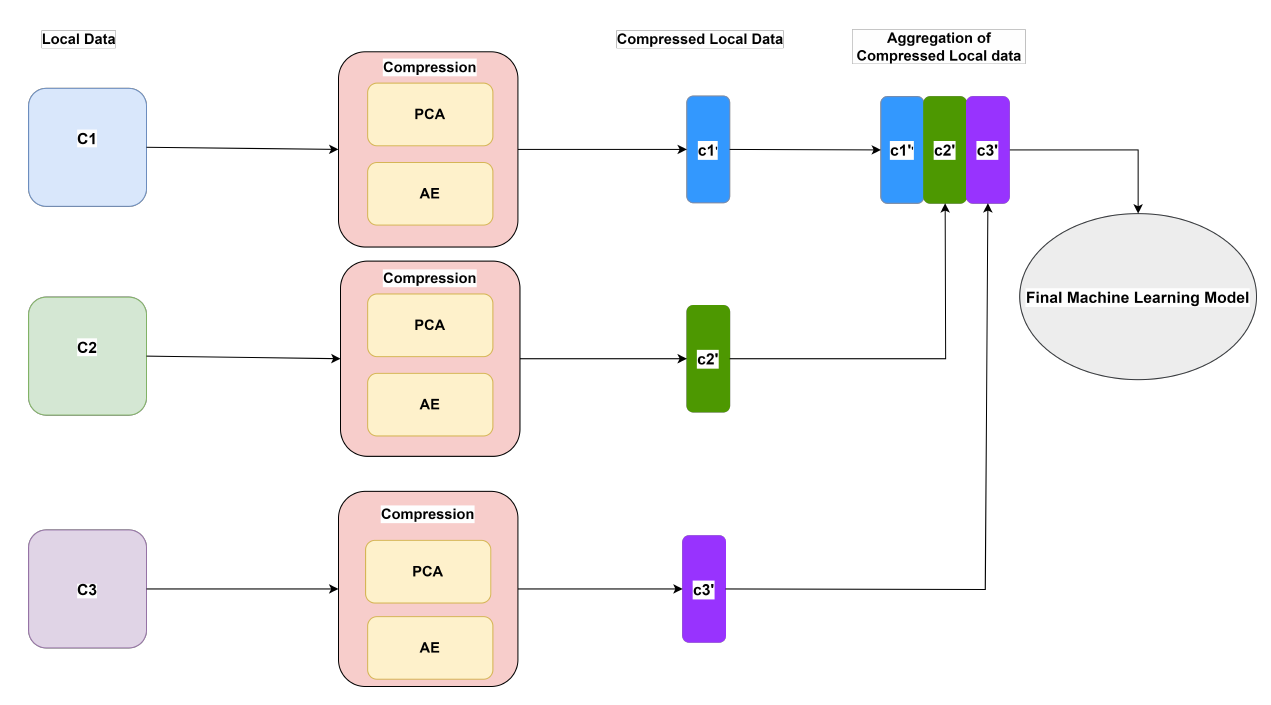
Figure 2. Architecture of Proposed